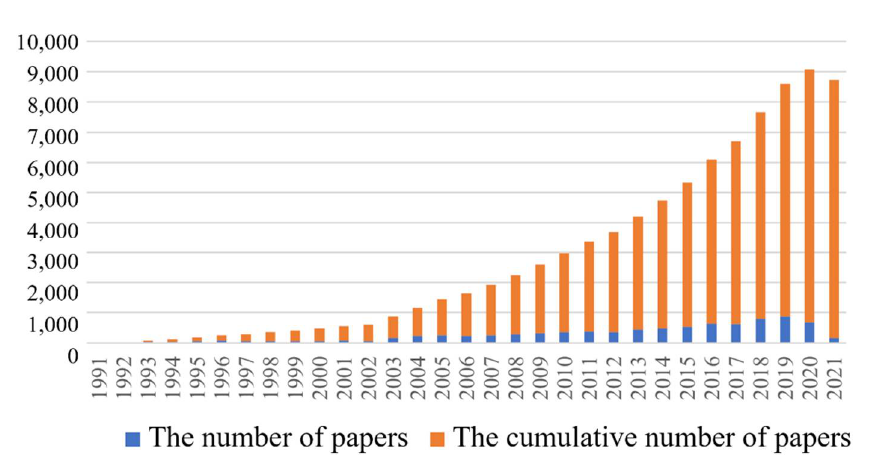
Figure 1. The number of papers and the cumulative number of papers, 8567, published in the academic field of lean production from 1 January 1991 to 6 April 2021.